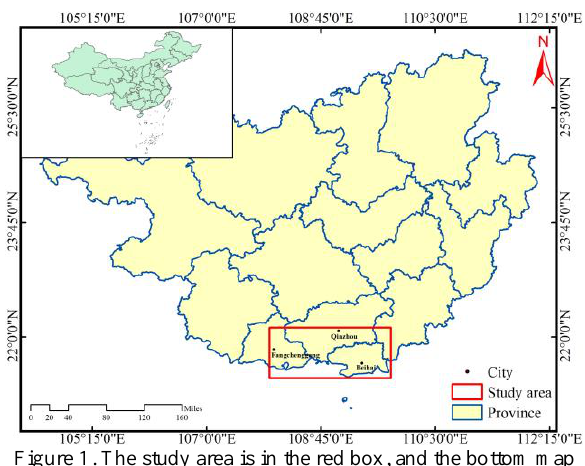
Figure 1. The study area is in the red box, and the bottom map is the boundary map of Guangxi municipalities.